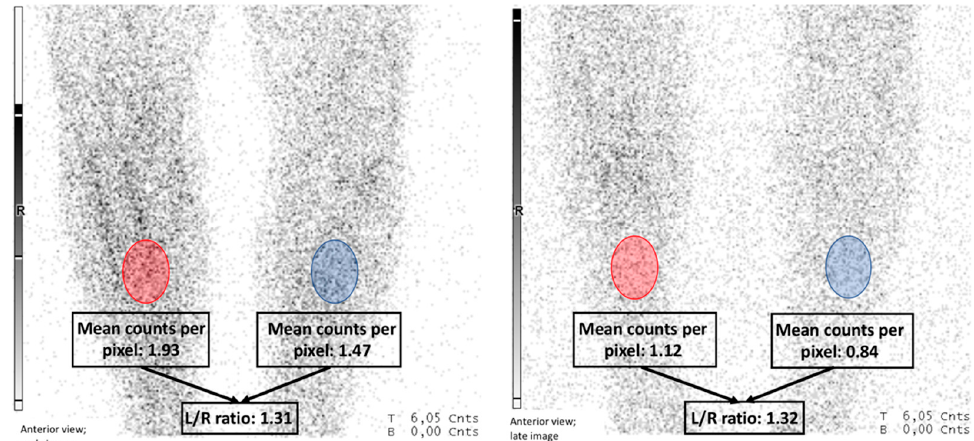
Figure 1. Example of L/R ratio calculation using semiquantitative analysis. L/R ratio calculation for the early ( left image ) and late ( right image ) scans of suspected FRI of a right tibial fracture. Red indicates the area of interest. Blue indicates the contralateral reference tissue. The mean counts per pixel were calculated within the selected area and the ratio was calculated in both the early and the late scans. In this case, the ratio remained stable between the early (L/R ratio of 1.3) and late (L/R ratio of 1.3) phases, which is considered negative for infection.